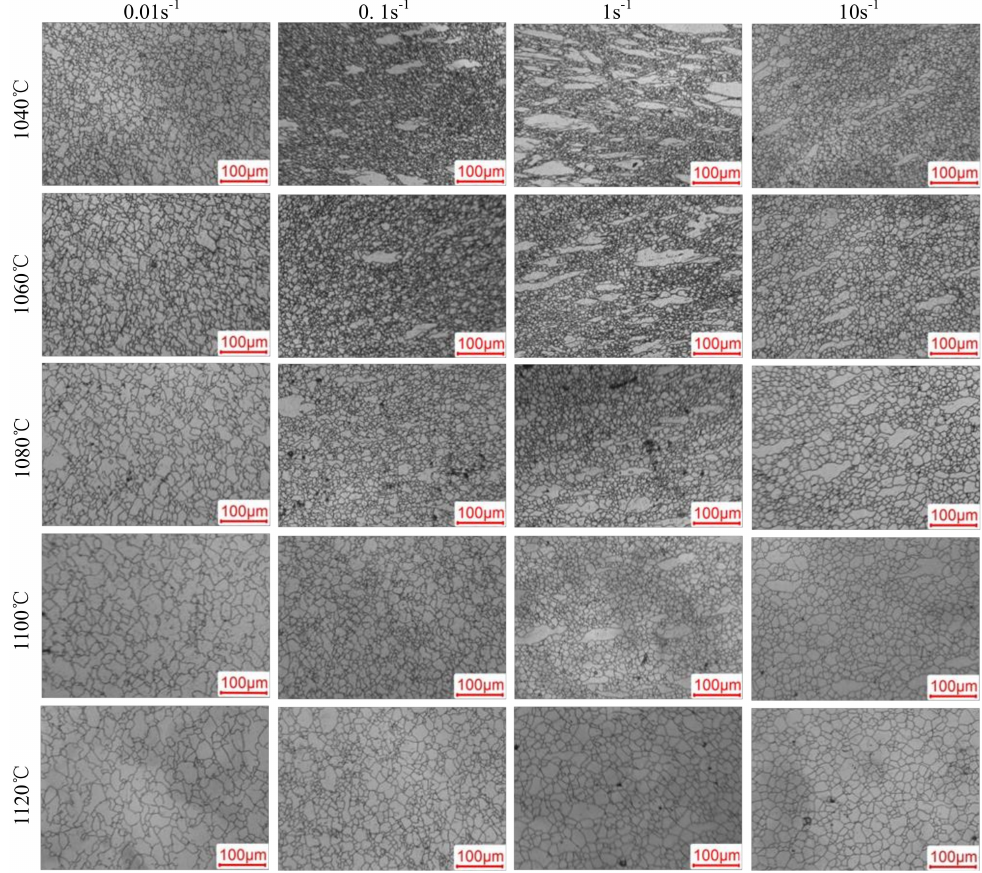
Figure 11. The microstructures of Waspaloy under different temperatures and strain